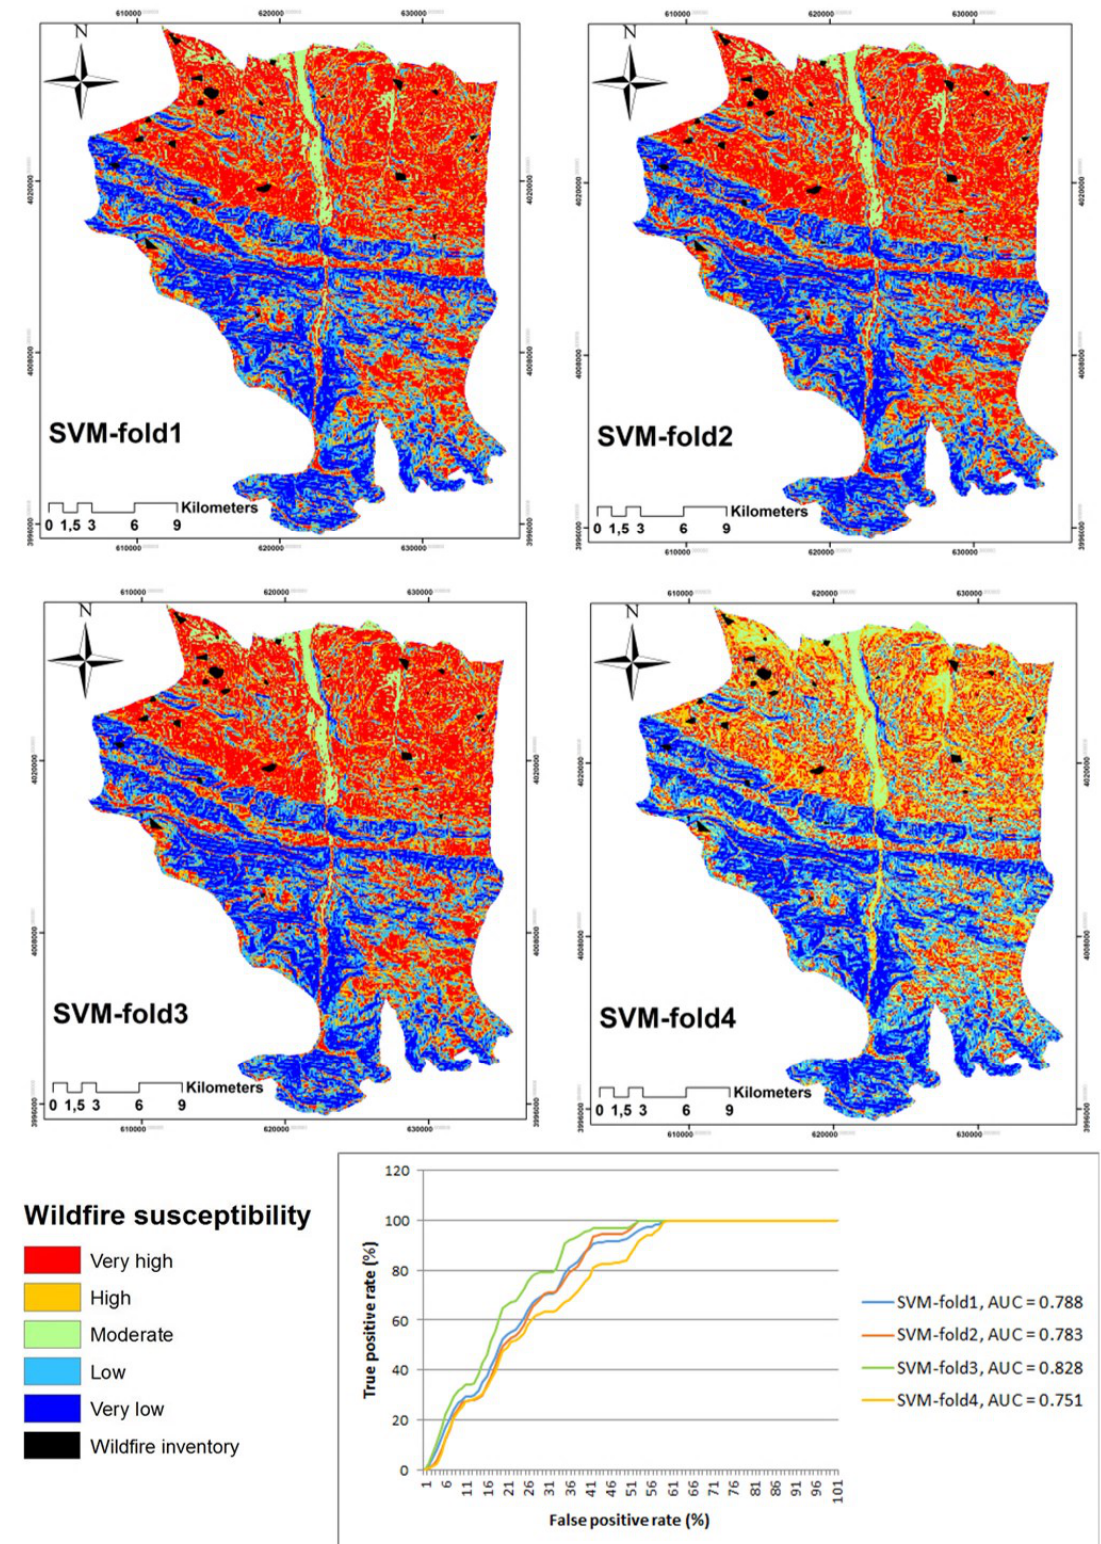
Figure 7. Spatial prediction of wildfire susceptibility maps using SVM and the AUC results based on four-fold